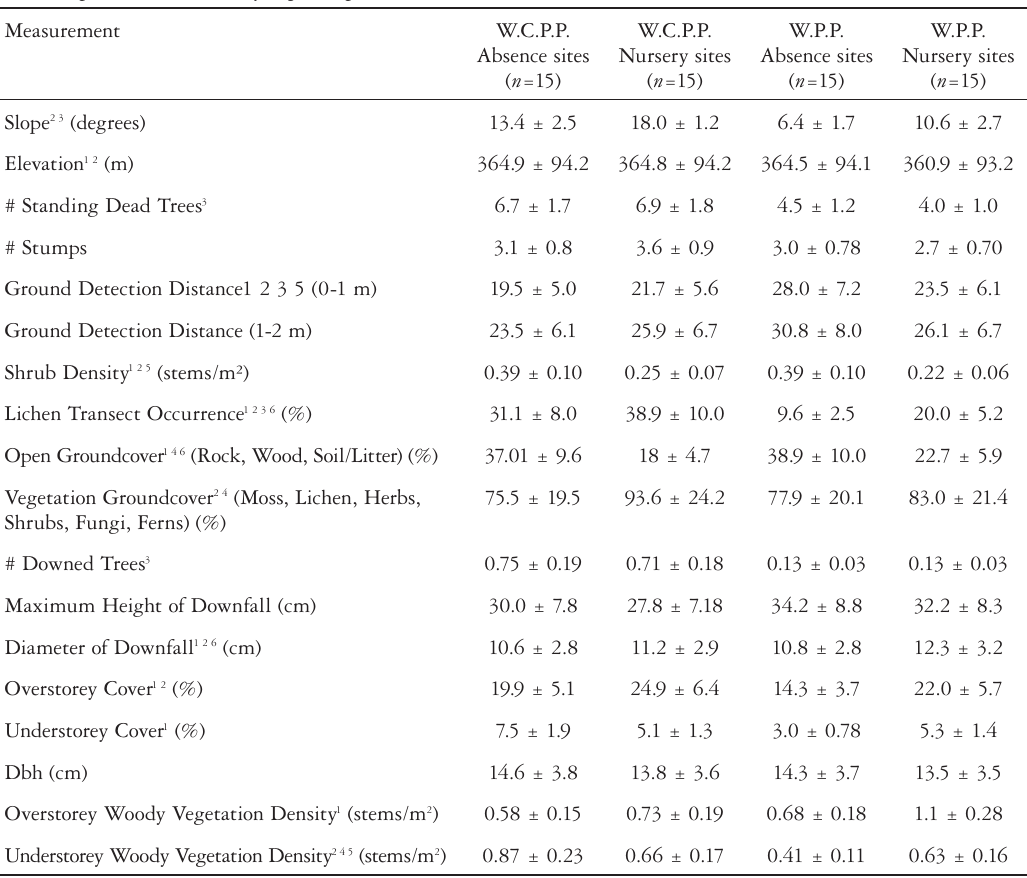
Table 1. Means ± standard errors of interval scale variables measured in sample plots at caribou nursery sites and ran- domly chosen absence sites on lakes in Wabakimi (W.P.P.) and Woodland Caribou Provincial Parks (W.C.P.P.), northern Ontario. Variables that showed significant differences in the MANOVA, individual park DFA results used to identify and determine variables most important in distinguishing nursery sites from absence sites, and variables used in the development and evaluation of Resource Selection Functions for calving caribou in each park are indicated by